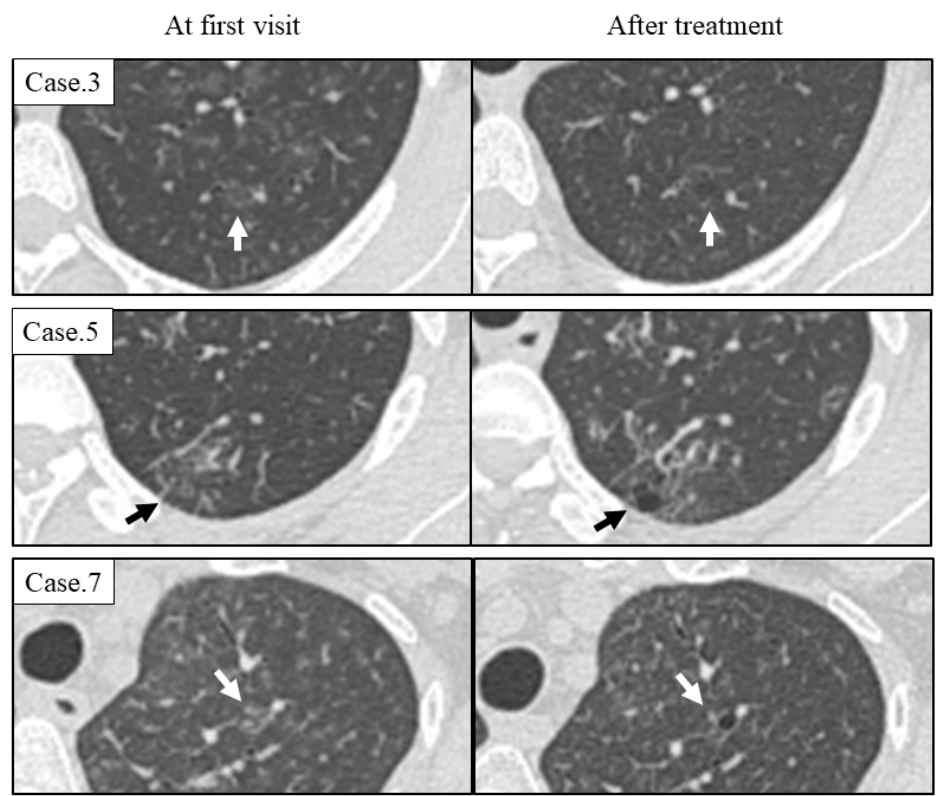
Figure 2. Chest high-resolution computed tomography imaging of cases with newly emerged cysts during the course. A new cyst emerged from the site of ground-glass attenuation on HRCT at the time of initial diagnosis (arrow). The cyst appeared despite the improvement of the ground-glass a tt enuation with treatment.